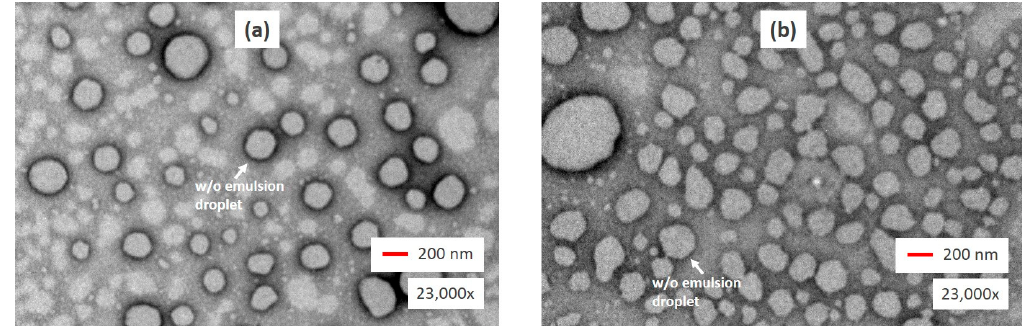
Figure 3. TEM images of the w/o/w nanoemulsions magnified 23,000×: sample 1 ( a ) and sample 9 ( b ).